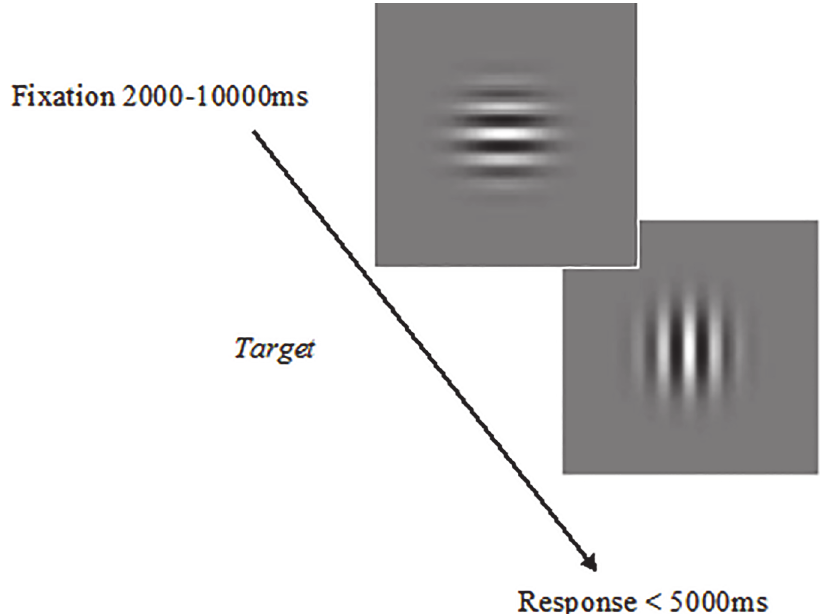
Fig 1. Schematic view of the temporal course of a trial sequence in the PVT (from top left to bottom right).